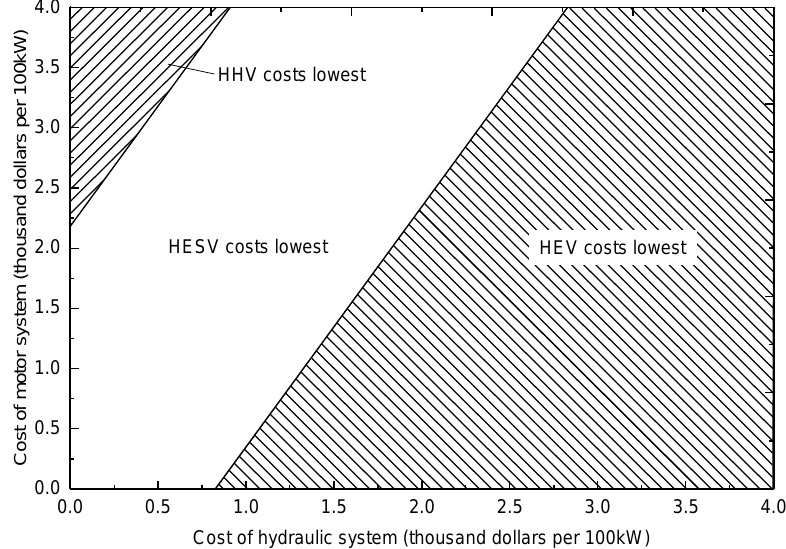
Figure 15. Illustration of the total operating cost of three hybrid vehicles.